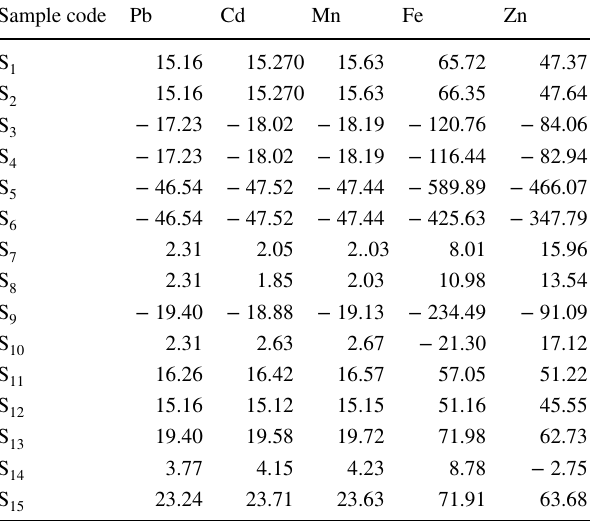
Table 12 Quantification of contamination (QoC) values of HMs in the water samples of Ibadan metropolis Sample code Pb